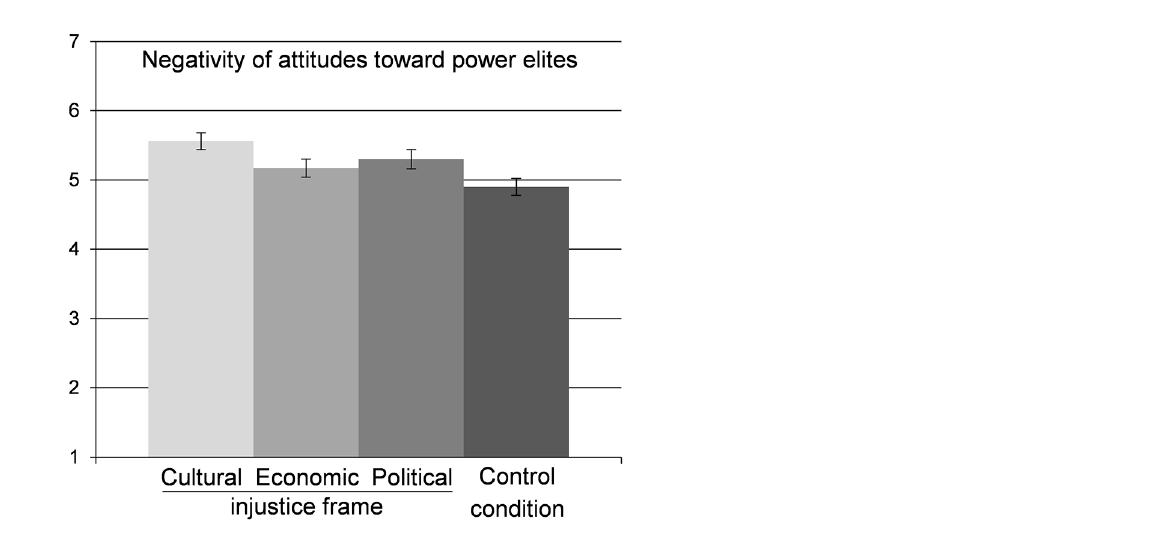
Figure 2. Negative attitudes toward power elites as a function of injustice frame (Experiment 2). Error bars represent ± 1